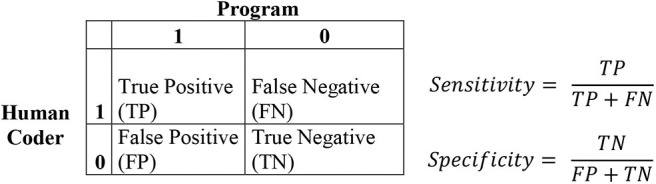
Classification method for the categories.